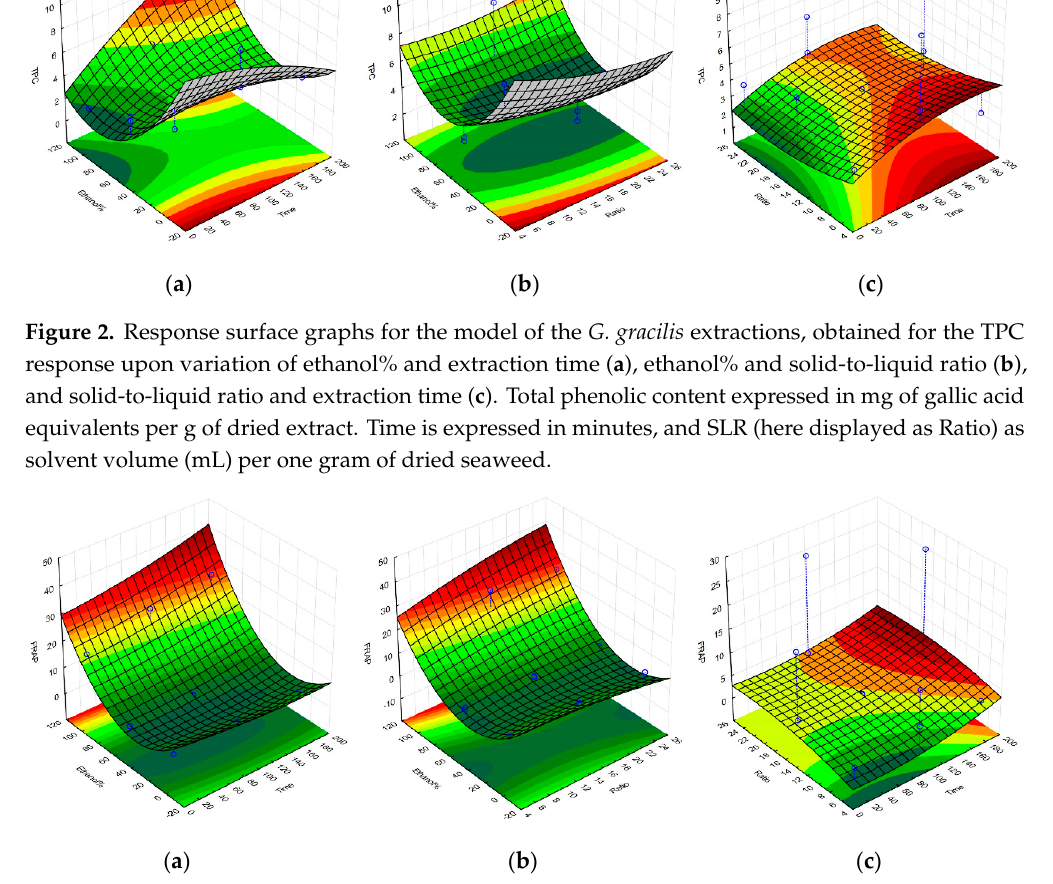
Figure 3. Response surface graphs for the model of the G. gracilis extractions, obtained for the FRAP response upon variation of ethanol% and extraction time ( a ), ethanol% and solid-to-liquid ratio ( b ), and solid-to-liquid ratio and extraction time ( c ). FRAP activity expressed in µmol of ascorbic acid equivalents per g of dried extract. Time is expressed in minutes, and SLR (here displayed as Ratio) as solvent volume (mL) per one gram of dried seaweed.